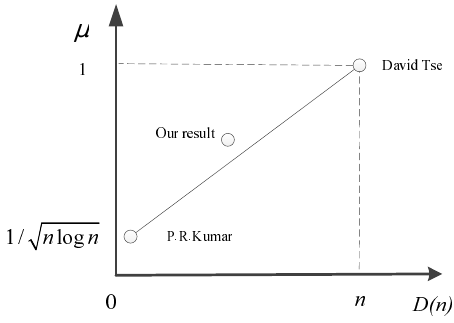
Figure 6. Throughput capacity and network delay